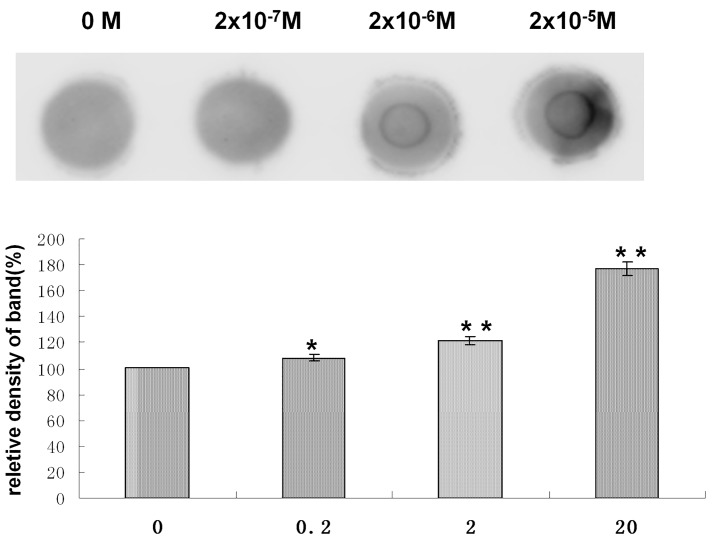
Effects of DES on global DNA methylation in GC-2 cells.The DNA 5-mC level was estimated by dot blot analysis. The gray values indicated DNA methylation levels.